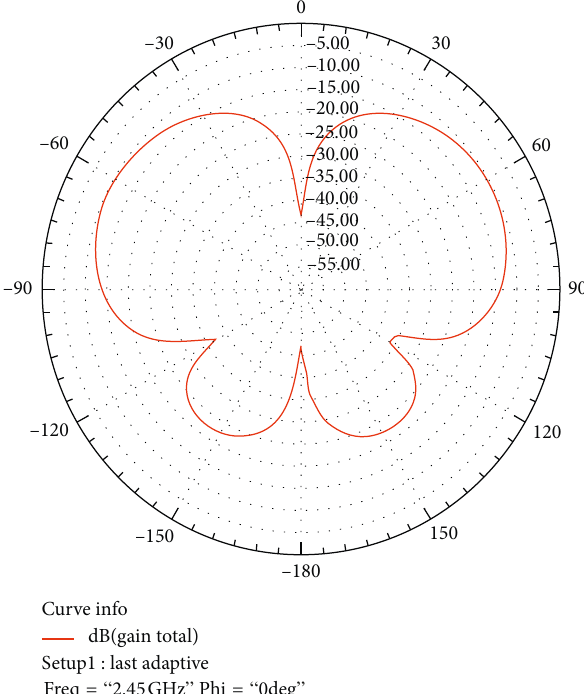
Figure 4: Radiation pattern of the coaxial antenna (with helical slots).